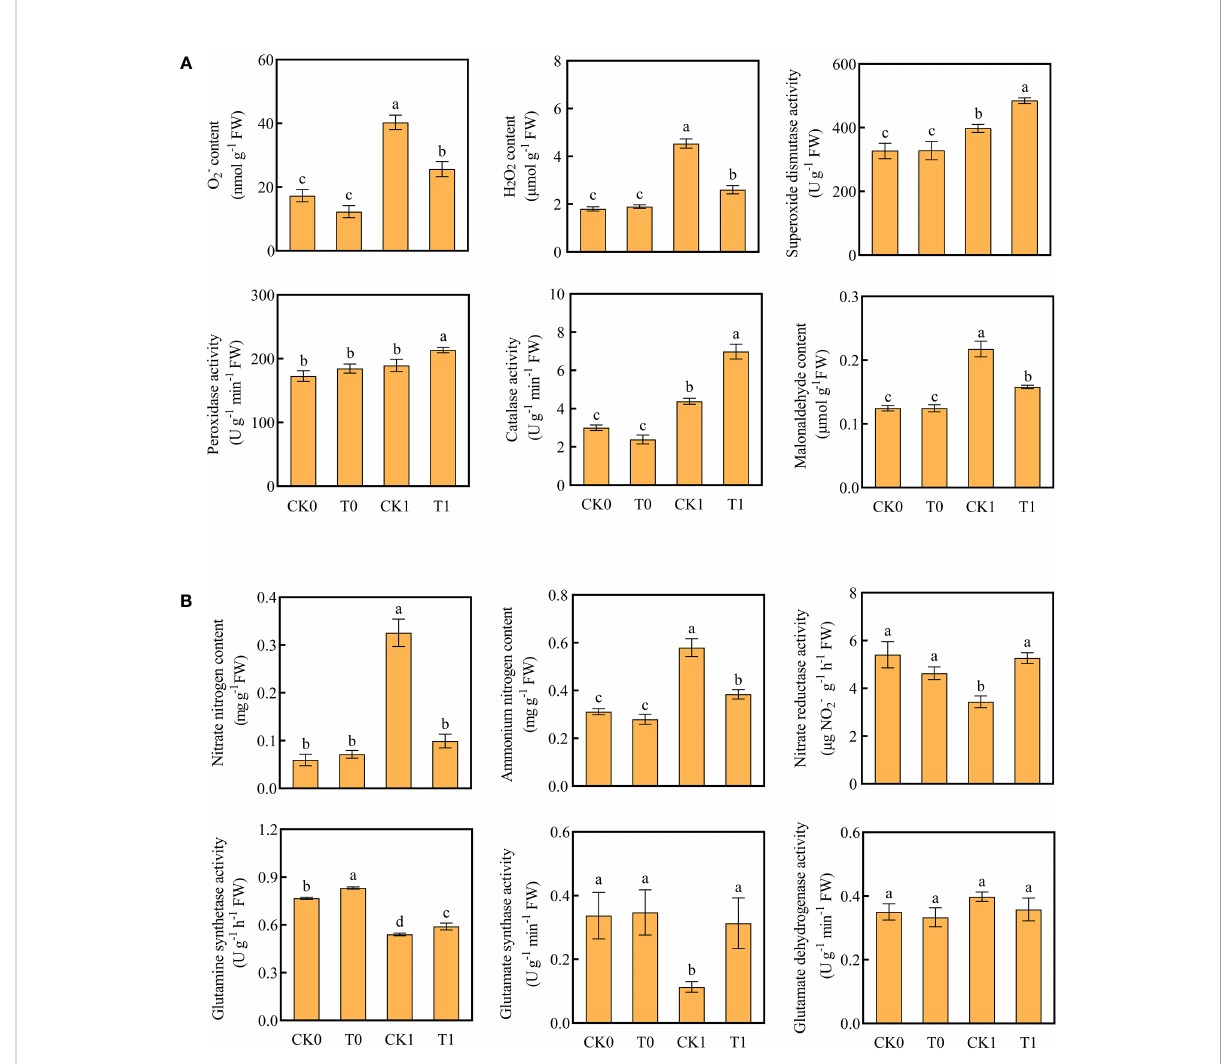
FIGURE 2 Contents of O 2- , H 2 O 2 , MDA, antioxidant enzyme activities (A) and contents of ammonium nitrogen, nitrate nitrogen, nitrogen metabolizing enzyme activity (B) in the four treatments. Data are presented as the mean ± SEM for six biological replicate samples and each sample included 3 plants. Bars labeled with different letters for signi fi cant difference between